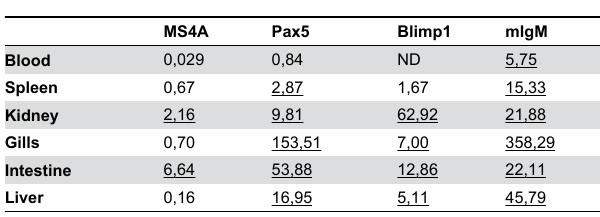
Table 4. Ratio of MS4A, Pax5 Blimp1 and membrane IgM (mIgM) transcription in IgM + cells in comparison to levels detected in the corresponding negative fractions (IgM + : IgM - ).